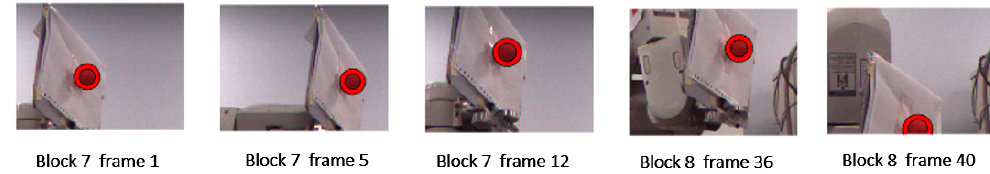
Figure 7. Search windows generated by IIM.